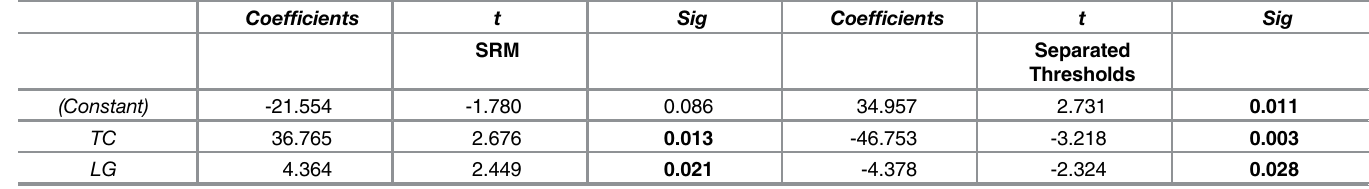
Table 3. Predictive model of spatial release from masking and separated thresholds based on tracking capacity (TC, for ndots = 3) and listener group (LG) as predictor